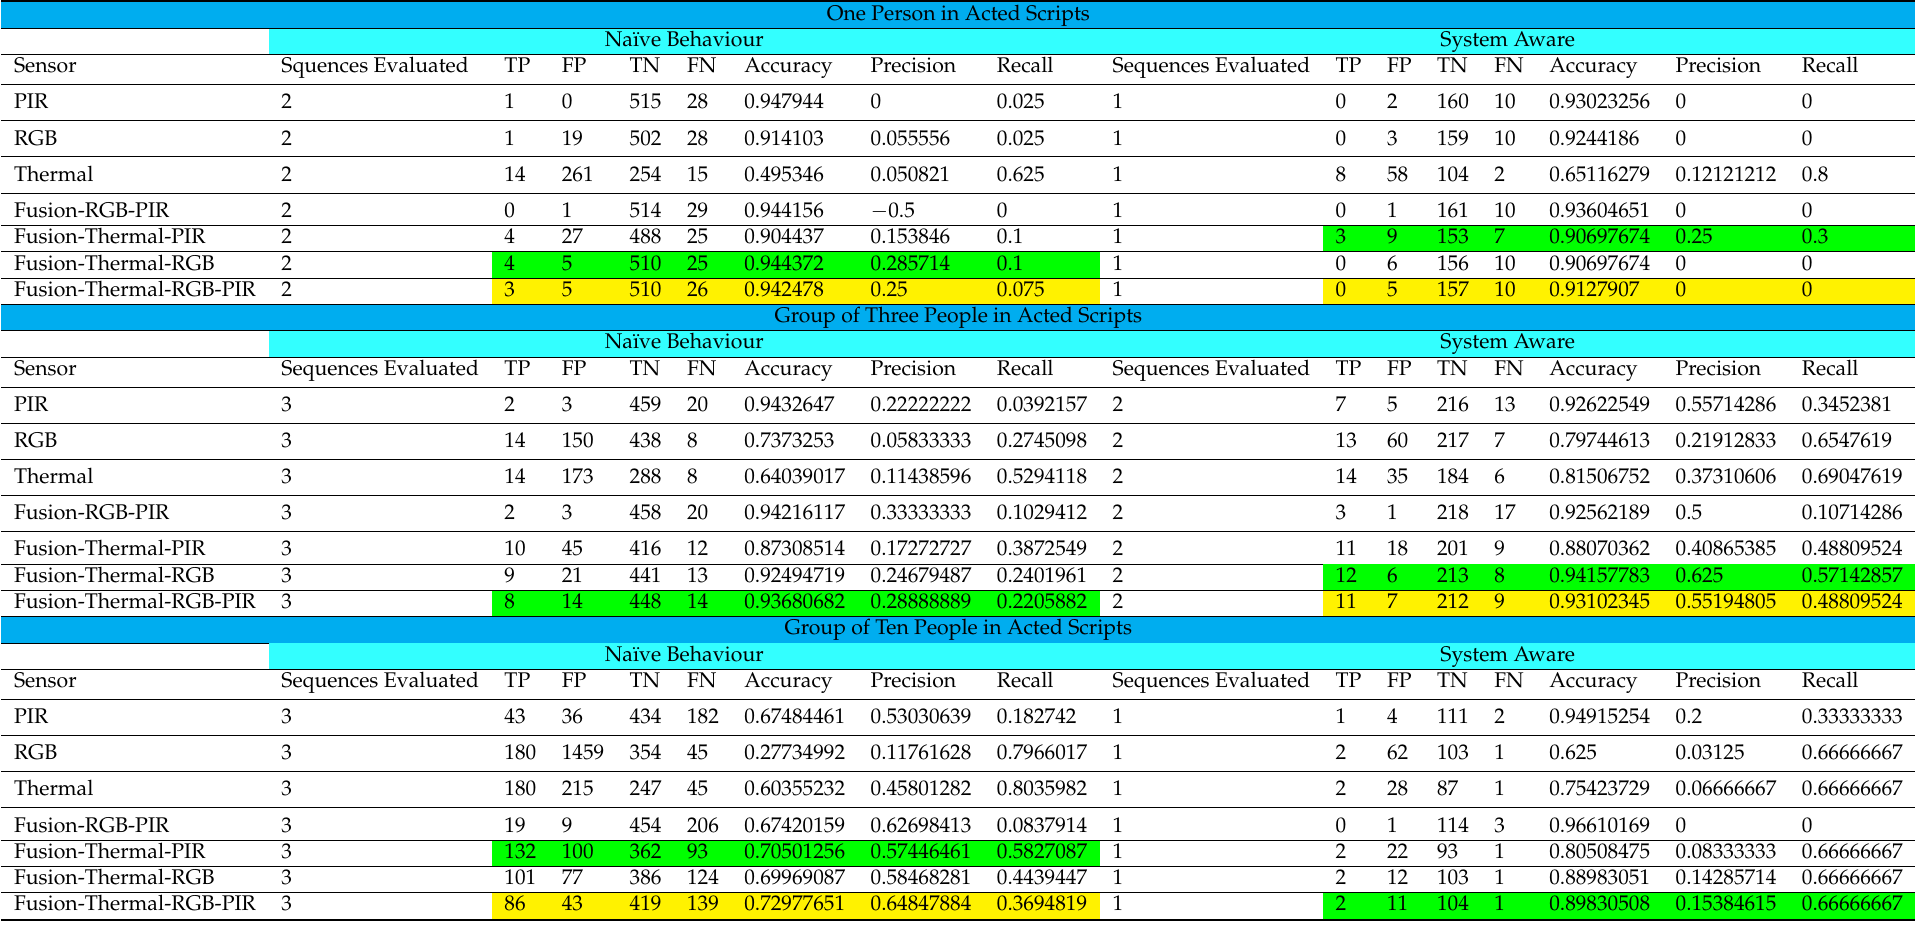
Table 5. Comparison of detections from single and fused sensors according to different group sizes and behaviour. The best system performance by category is highlighted in green and the second best performance is highlighted in